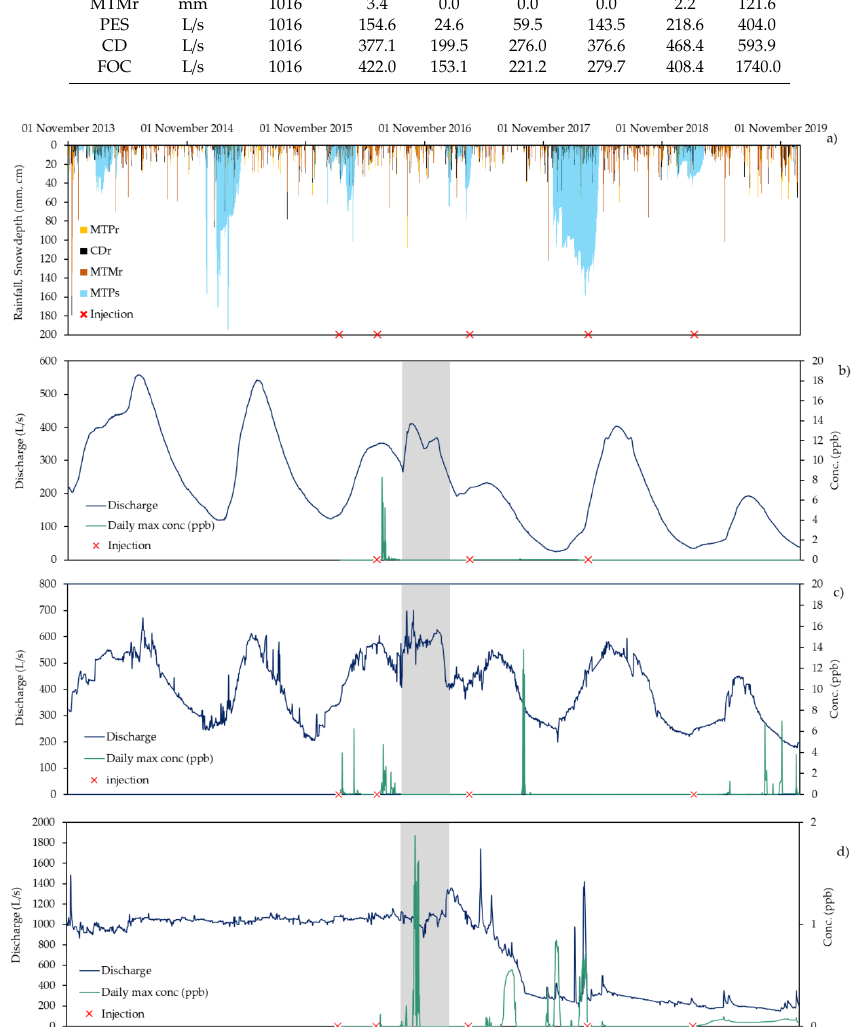
Figure 2. Graphs of the considered time-series: ( a ) Daily rainfall recorded at Mount Prata rain (MTPr), Capodacqua rain (CDr), and Montemonaco rain (MTMr) gauges and snow cover thickness data measured at Mount Prata snow (MTPs) gauge starting from November 2013 to December 2019. The red crosses represent the injection of tracer in the Mèrgani sinkhole. Daily discharge expressed in L/s and tracer maximum concentration expressed in ppb, recorded at ( b ) Pescara springs (PES), ( c ) Capodacqua (CD), and d) Foce spring (FOC), respectively, starting from November 2013 to December 2019. In those cases, the red crosses represent the presence of a fluorimetric probe in the monitoring points. The grey zone represents the most intensive seismic period (24 August 2016–18 January 2017).